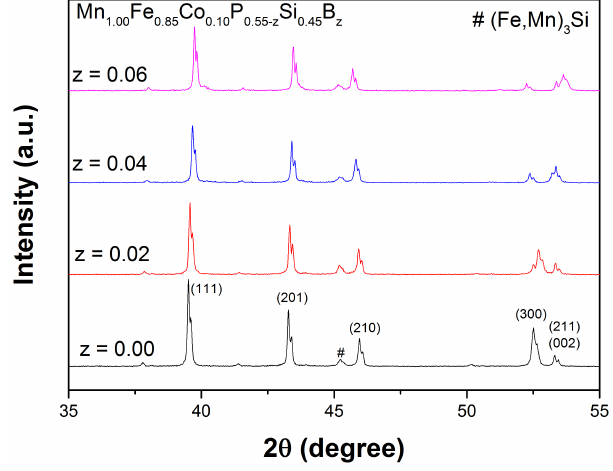
Figure 1. X-ray diffraction (XRD) patterns measured at 400 K ( T > T C ) for the